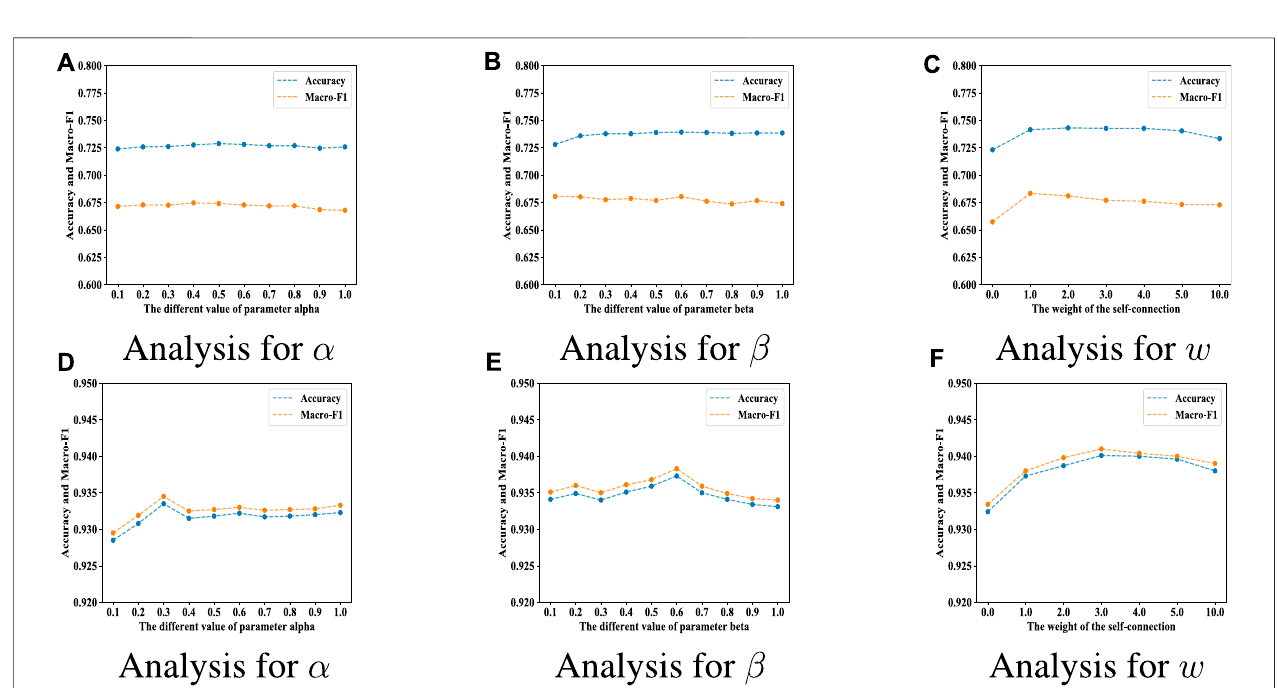
FIGURE 4 | The performance of our method for parameters α , β , w on the Citeseer (A – C) and ACM (D – F) datasets for node classi fi cation task.